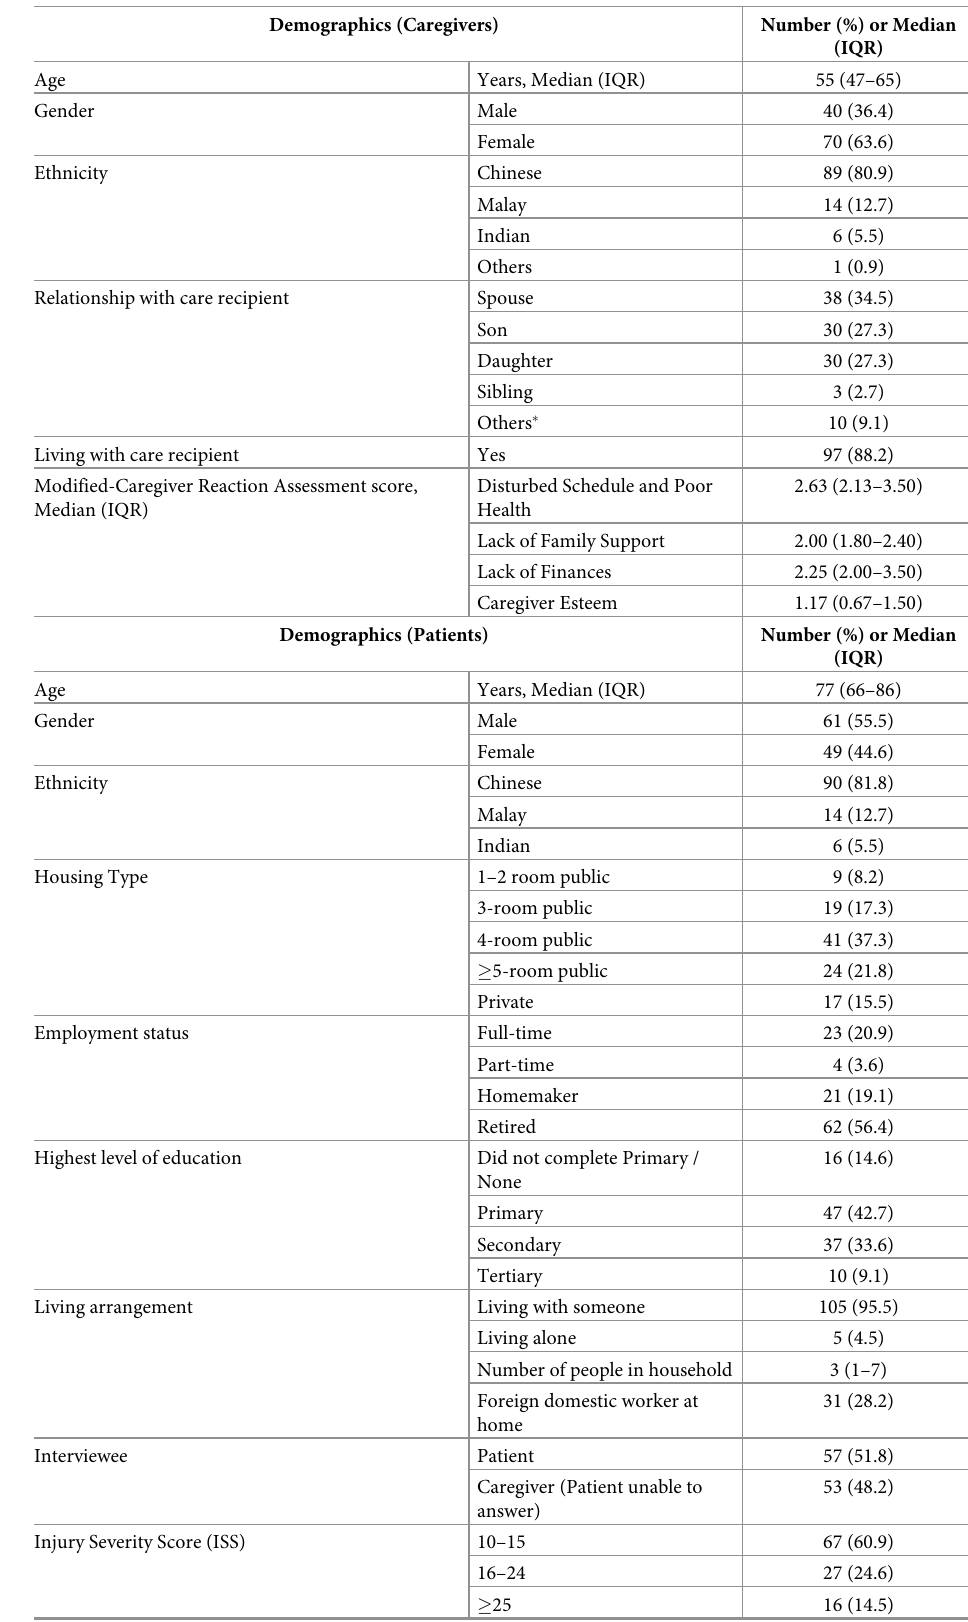
Table 1. Characteristics of older blunt trauma patients and their caregivers (n =